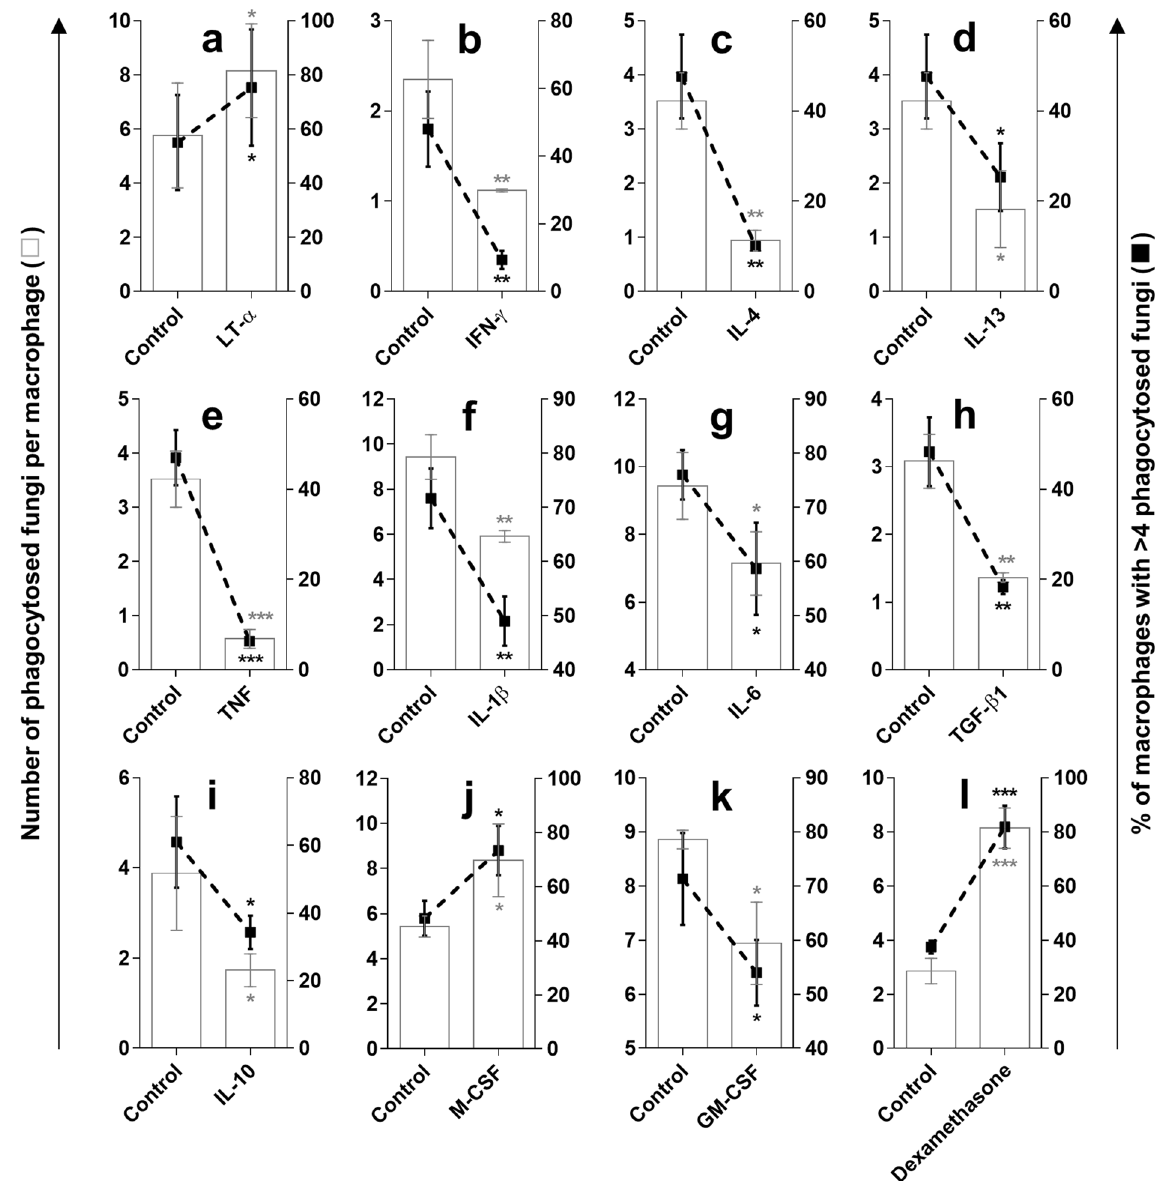
Figure 8. Effects of cytokines on the phagocytosis of C . albicans by MDM. MDM were prepared by culturing human monocytes for 5 days. The MDM were treated with 40 ng/ml of LT- α ( a ), IFN- γ ( b ), IL-4 ( c ), IL-13 ( d ), or 20 ng/ml TNF ( e ), or 40 ng/ml IL-1 β ( f ), IL-6 ( g ), or 15 ng/ml TGF- β 1 ( h ) or 40 ng/ml IL-10 ( i ), M-CSF/GM- CSF ( j , k ) or 50 ng/ml dexamethasone ( l ) for 24 h and examined for their ability to phagocytose complement opsonised C . albicans . Phagocytosis was scored as both the number of macrophages that had engulfed more than > 4 fungi (line graph) and the number of fungi engulfed per cell (bar graph). Data are presented as means ± SD of three experiments, each conducted with cells from different individuals, * p < 0.05, ** p < 0.01, *** p <